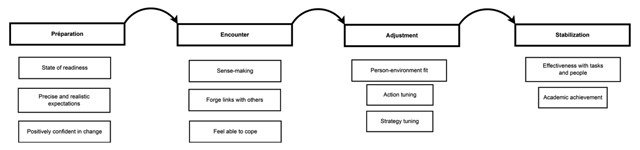
Nicholson’s Transition Cycle (1990) adapted to the context of first year at the university.